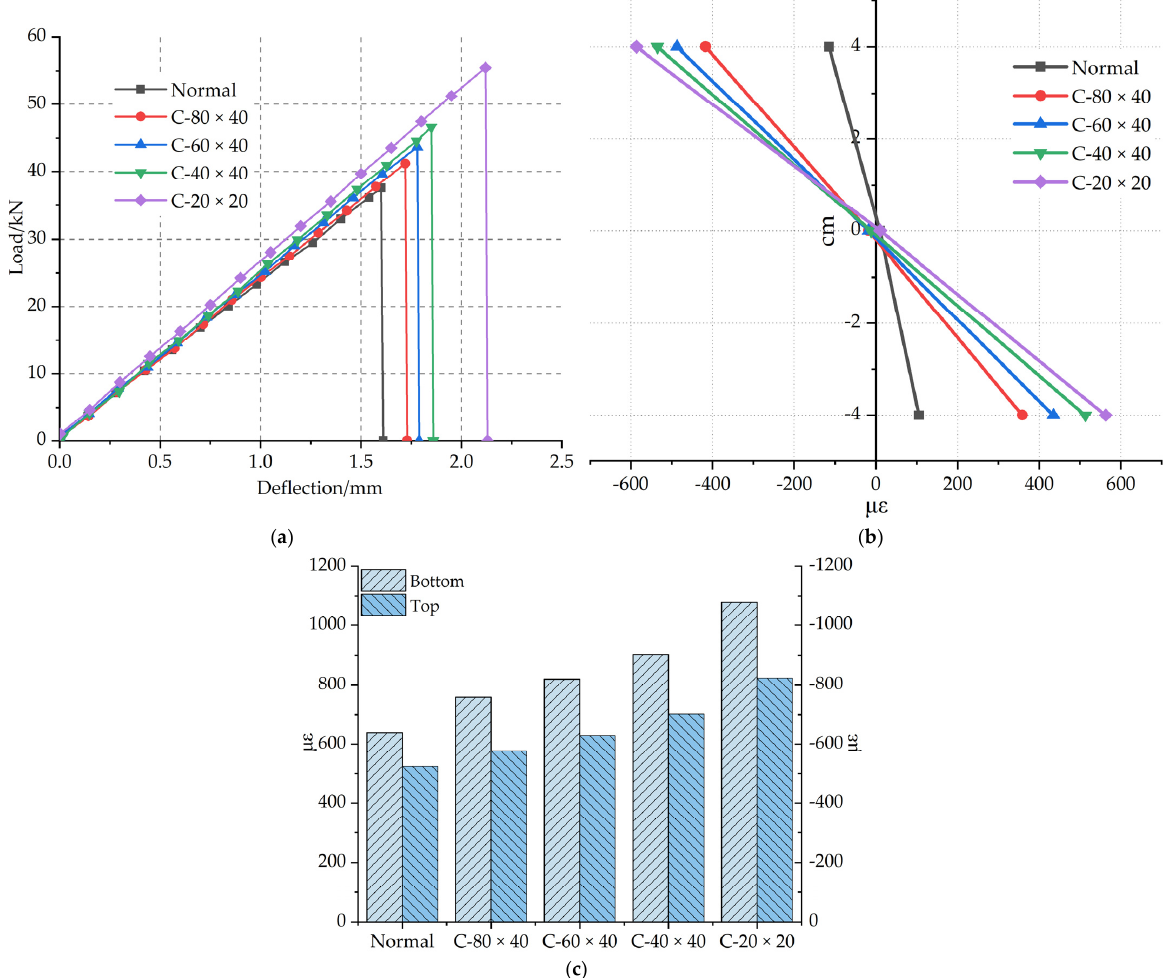
Figure 16 . ( a ) Load–deflection curves of different grid densities. ( b ) High failure strain along the beam height with different grid densities. ( c ) Failure strain at the bottom and top of beams with different grid densities.